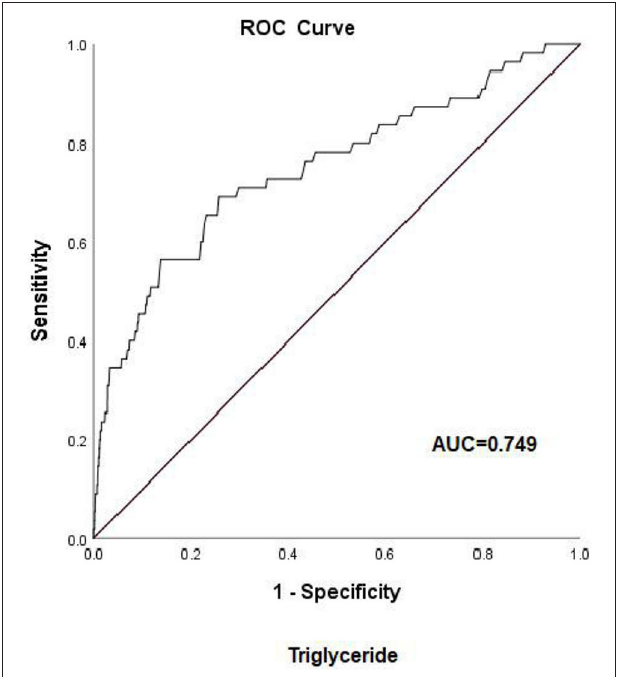
FIGURE 2 | Receiver operating characteristic (ROC) curve analysis for predicting early-onset pre-eclampsia on the basis of maternal triglycerides (24–28 weeks of gestation). AUC, area under the curve.